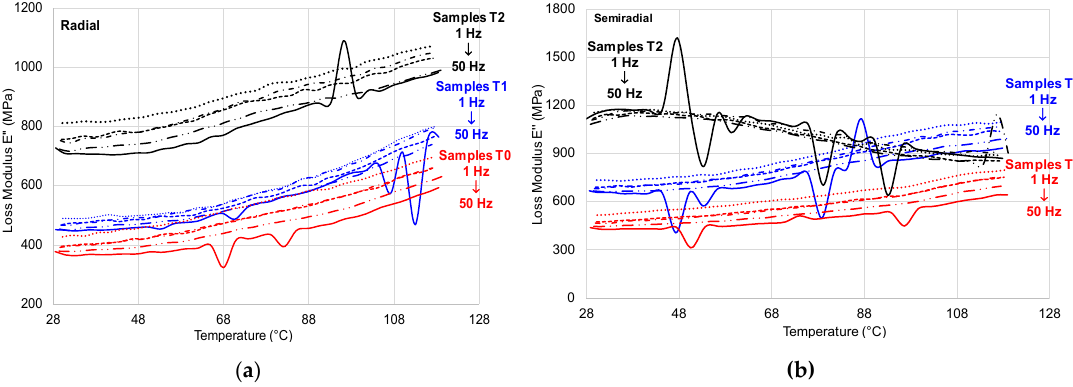
Figure 14. Variation of loss modulus E ” with temperature: ( a ) samples cut in radial–longitudinal direction; ( b )samples cut in semi-radial–longitudinal direction. Legend: red line—untreated samples; blue line—samples exposed to first ammonia treatment; black line - samples exposed to the second ammonia treatment; solid line (50 Hz); long dash dot dot line (10 Hz); dash dot line (5 Hz); square dot line (3.3 Hz); round dot line (1 Hz).